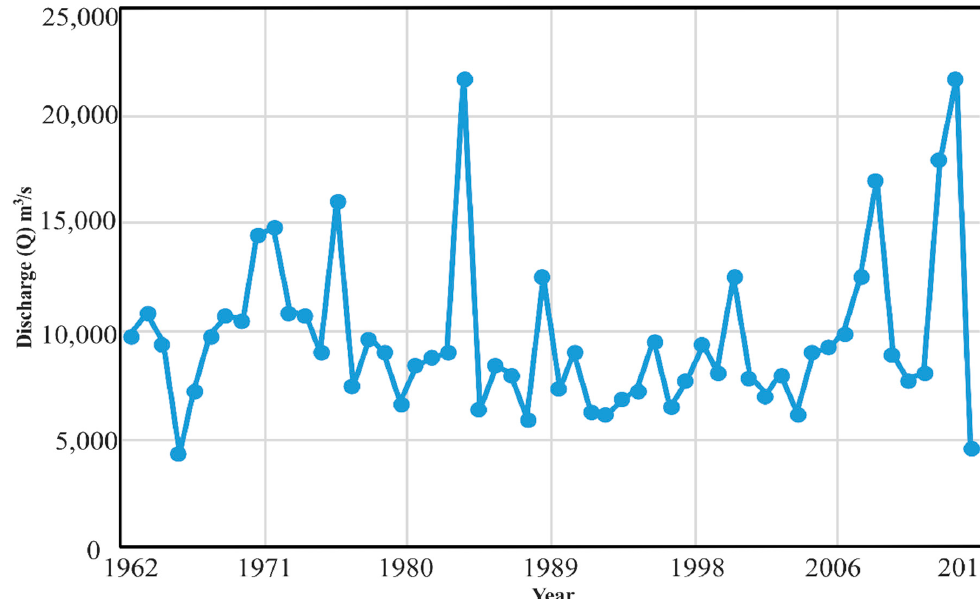
Figure 3. Instantaneous record of Karnali–Chisapani station from 1962 to 2015.